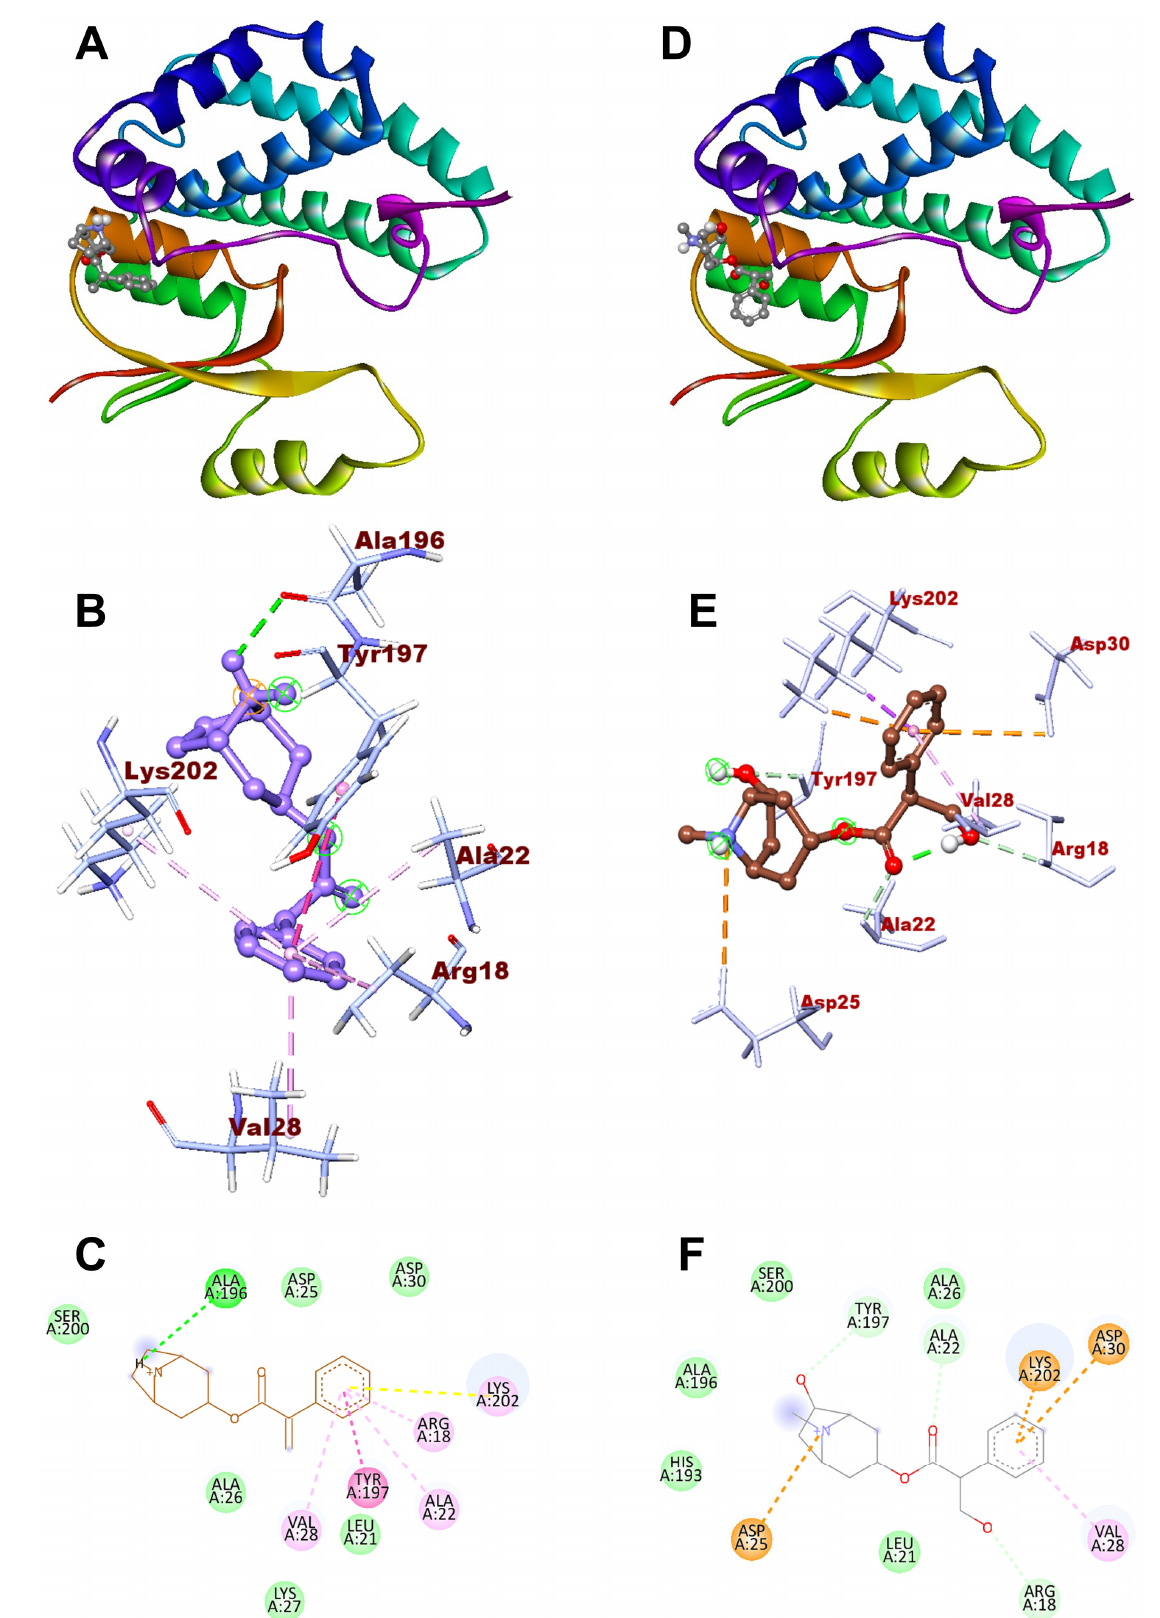
Figure 4. ( A , B ) Docking of norapoatropine with binding sites of RmGST’s 3D complex structure and ( C ) their 2D interaction. ( D , E ) Docking of 7-hydroxyhyoscyamine with binding sites of RmGST’s 3D complex structure and ( F ) their 2D interaction.